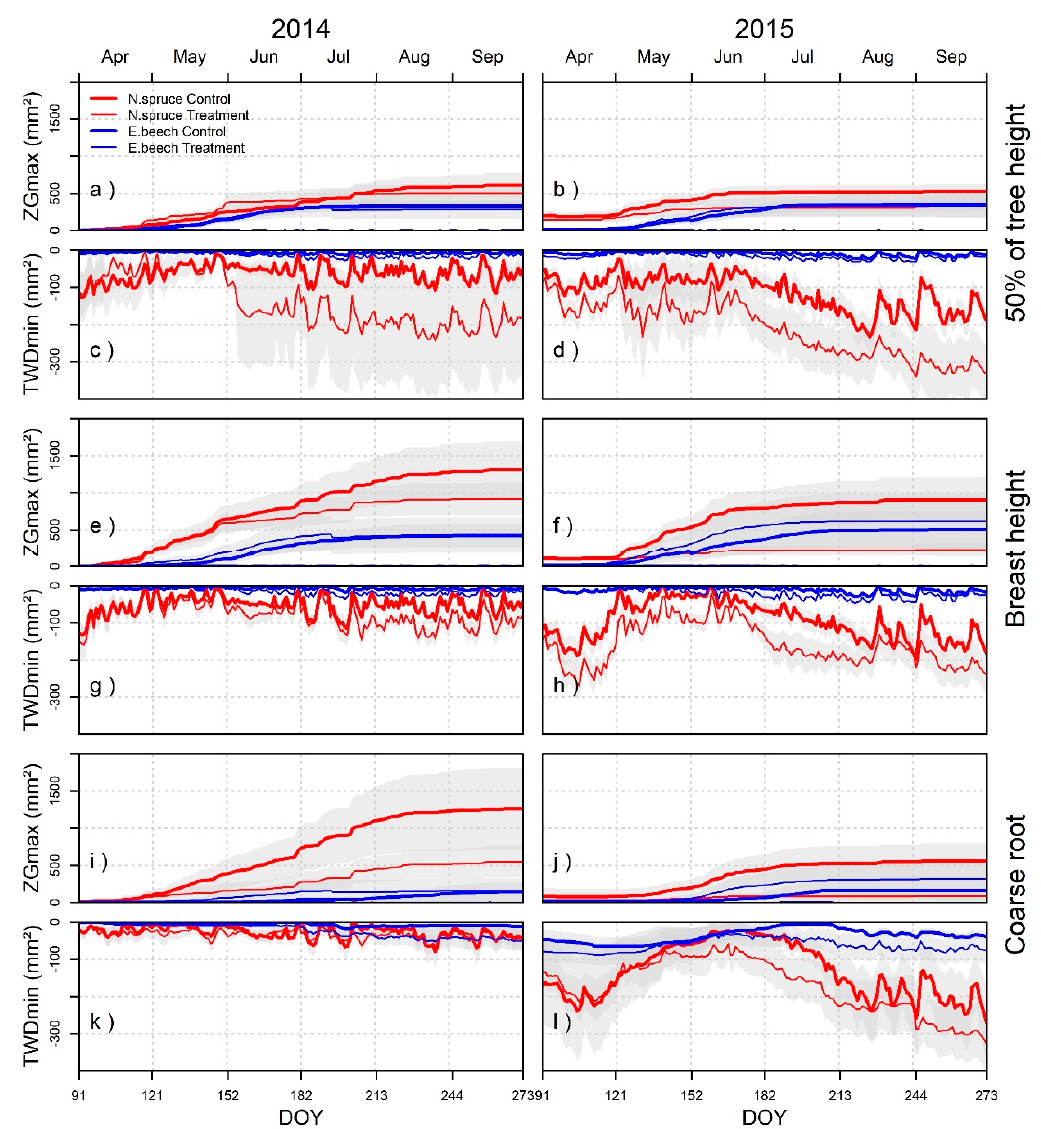
Figure 3. Mean TWDmin and zero growth (growth without the water signal) referring to the stem/root basal area (mm²) for the years 2014 (left) and 2015 (right) for spruce (red) and beech (blue) at the control (thick line) and treatment (thin line) plots at 50% tree height ( a – d ), breast height (BH, e – h ), and roots ( i – l ). Shaded regions are confidence intervals. Data are shown for the growing season.